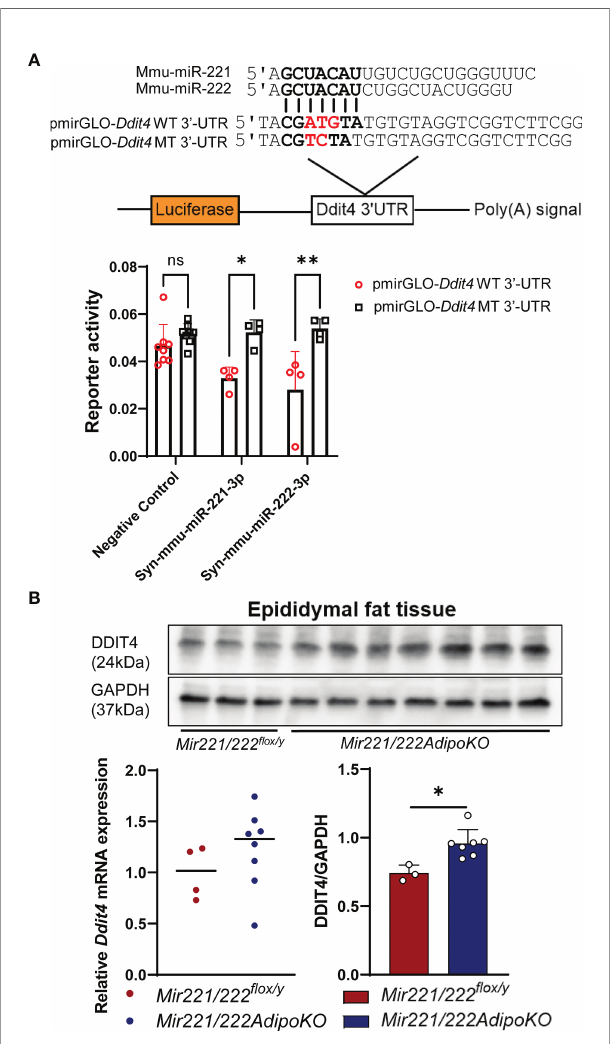
FIGURE 3 | Dual-luciferase reporter assay for Ddit4 3 ’ UTR and expression of Ddit4 in mice. (A) Dual-luciferase reporter assay using pmirGLO -Ddit4 WT 3 ’ - UTR, pmirGLO -Ddit4 MT 3 ’ -UTR, and pmirGLO no-insert control plasmids. 3T3-L1 cells were co-transfected with Syn-mmu-miR-221-3p (n=4), Syn- mmu-miR-222-3p (n=4), negative control siRNA (n=8). (ns, not signi fi cant). (B) Quantitative RT-PCR for Ddit4 in epididymal adipose tissues of Mir221/ 222 fl ox/y (n=4) and Mir221/222AdipoKO (n=8) mice fed with high fat high sucrose (HFHS). Western blot analyses for DDIT4 and GAPDH (glyceraldehyde- 3-phosphate dehydrogenase) in epididymal adipose tissues of Mir221/222 fl ox/y (n=3) and Mir221/222AdipoKO (n=7) mice fed with high fat high sucrose (HFHS). Data shown as mean ± SD and analyzed by Mann-Whitney ’ s U test (*p<0.05;